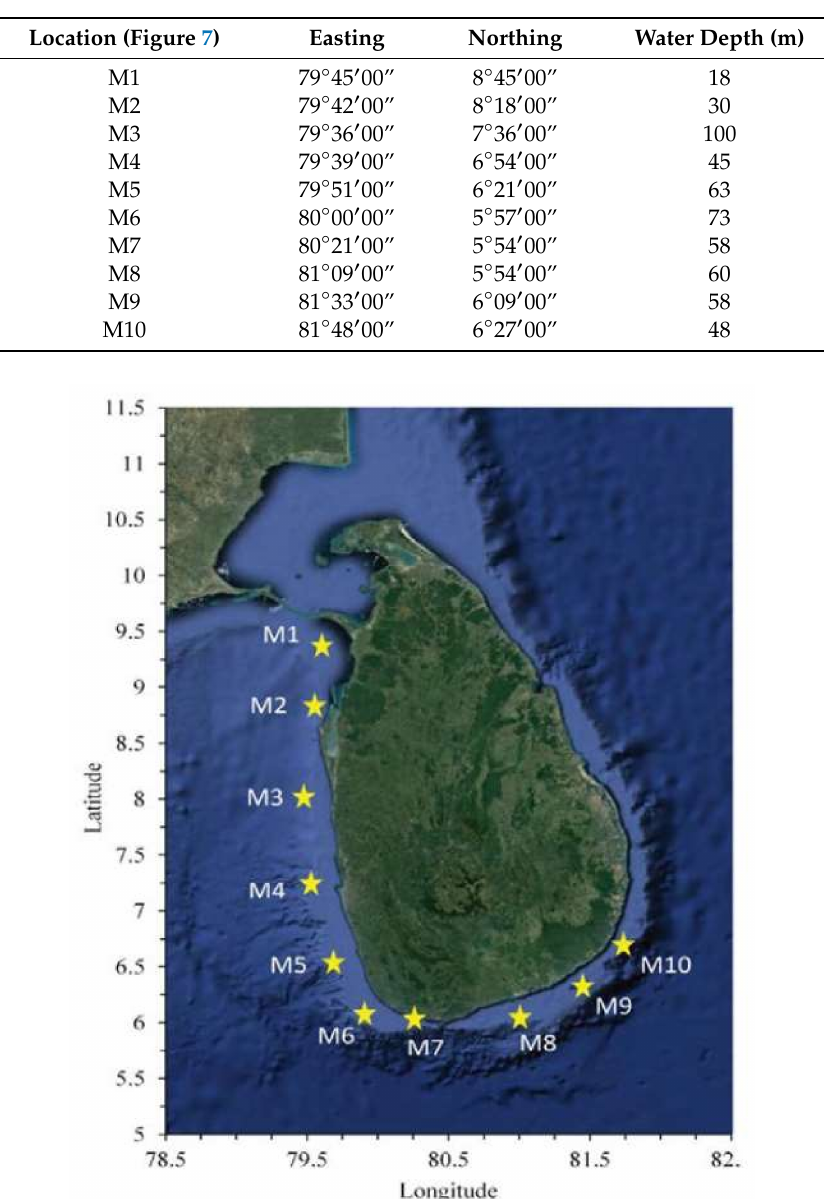
Table 2. Coordinates and water depths of locations selected for detailed analysis of climate change impacts on the wave resource around Sri Lanka.